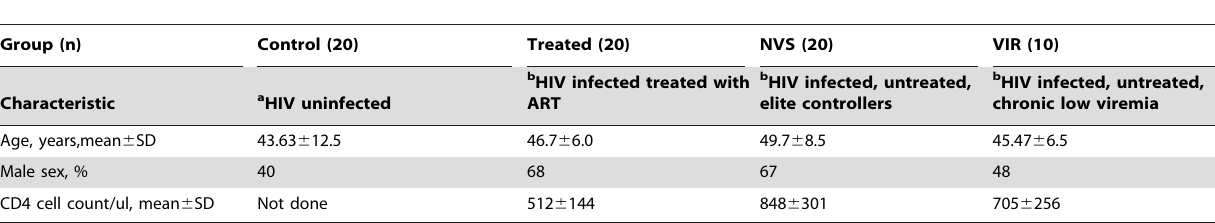
Table 1. Demographic and Clinical Characteristics of Patients and Control